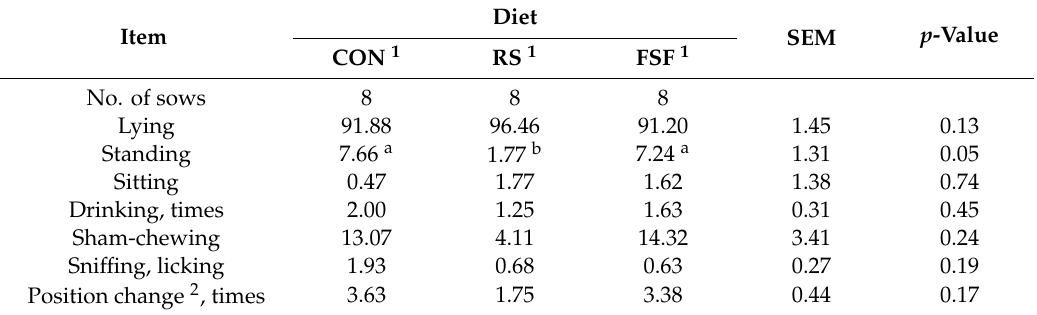
Table 5. Effect of inclusion of resistant starch (RS) or fermented soybean fiber (FSF) in gestation diet on behaviors of pregnant sows.